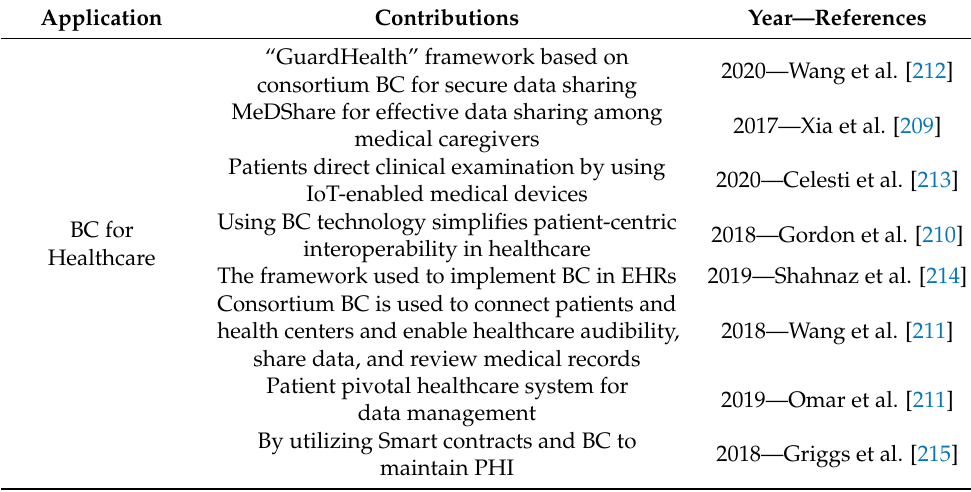
Table 4. Summary of convergence applications of IoT and BC for